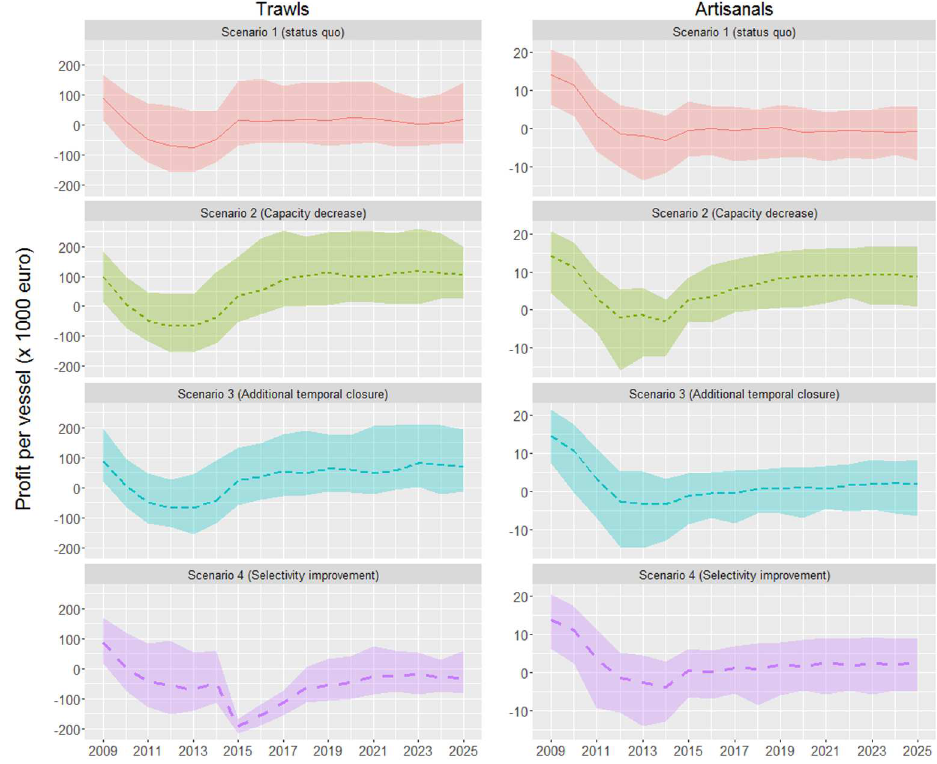
Fig 4. Profit per vessel(in 10 3 € ) for the trawl (left graph) and artisanal fleet (right graph) under the four simulated scenarios, assuming that fuel prices from 2016 onwards are equal to the 2015 mean rate. Lines indicatethe median estimates and the upper and lower limits of each ribbonrepresent the 0.1 and 0.9